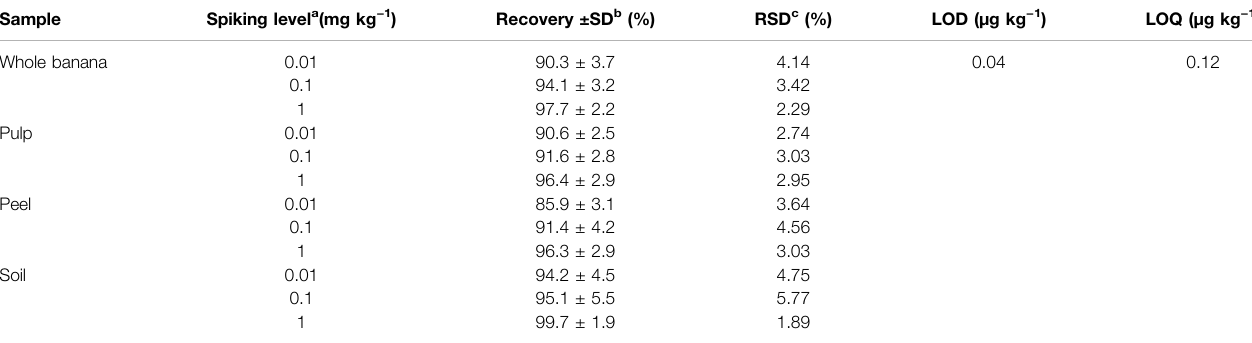
TABLE 1 | Average recovery, LODs, and LOQs of kresoxim-methyl in banana and soil. Sample